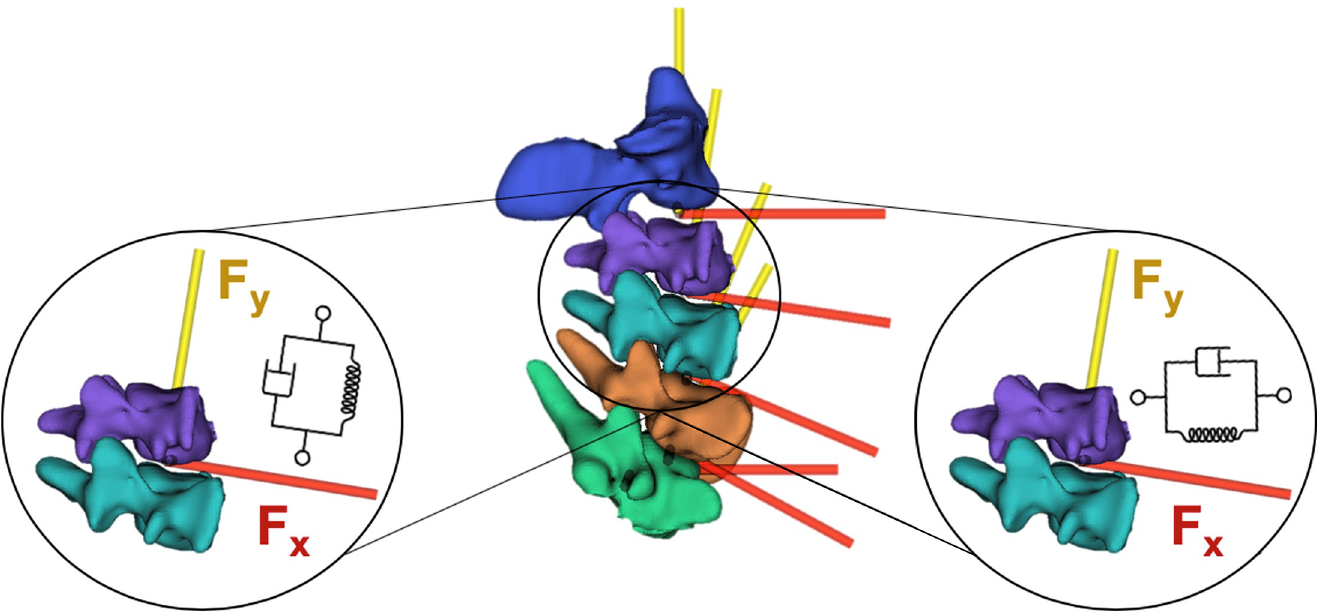
Fig 2. Joint and coincident 6 DOF viscoelastic bushing element locations. Only axial (Fy—left) and anteroposterior (Fx—right) viscoelastic elements were optimised, the parameters of the remaining four degrees of freedom remained at their initialised values.